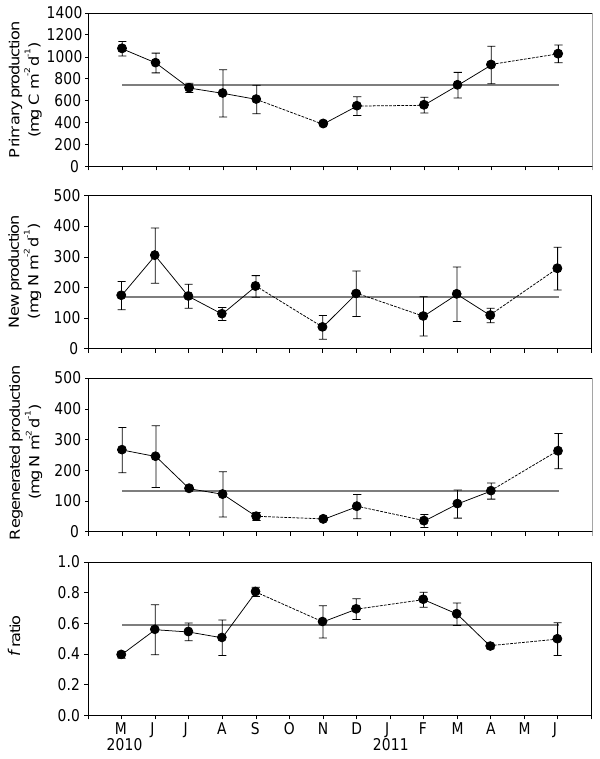
Fig. 8. Annual variations of integrated primary, new and regener- ated production, and f ratio in the Ulleung Basin during our study period. The grey line represents an average of each